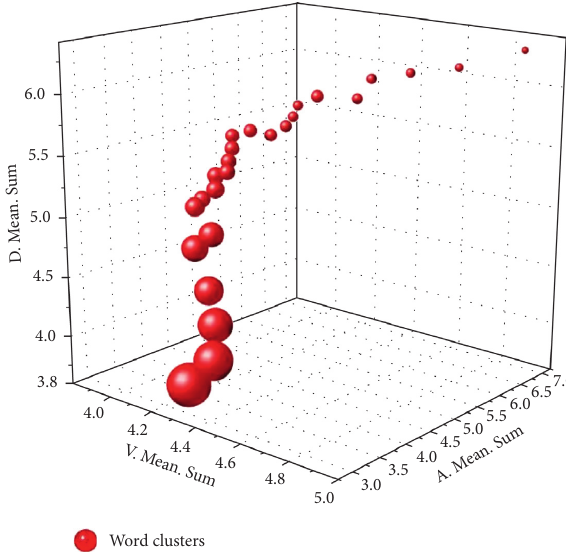
Figure 3: The size of 26 red balls presents the cumulative profits with a space composed of three emotional dimensions. The location of each red ball within the space is determined by the mean scores along three dimensions of each